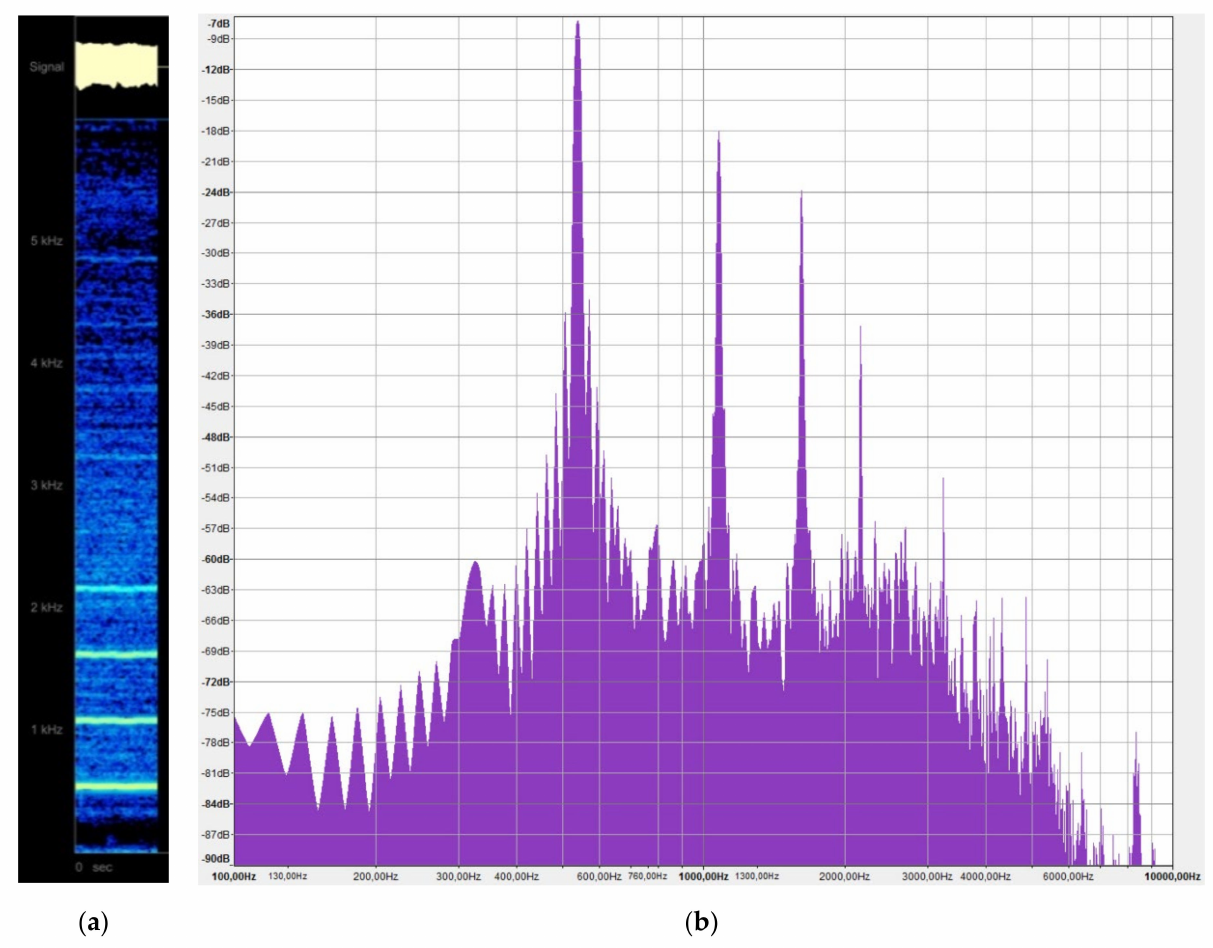
Figure 10. Spectral components of the shell horn made from Triplofusus princeps . Experimental model with ceramic mouthpiece, overblowing: ( a ) spectrogram; ( b ) spectrum (Sample